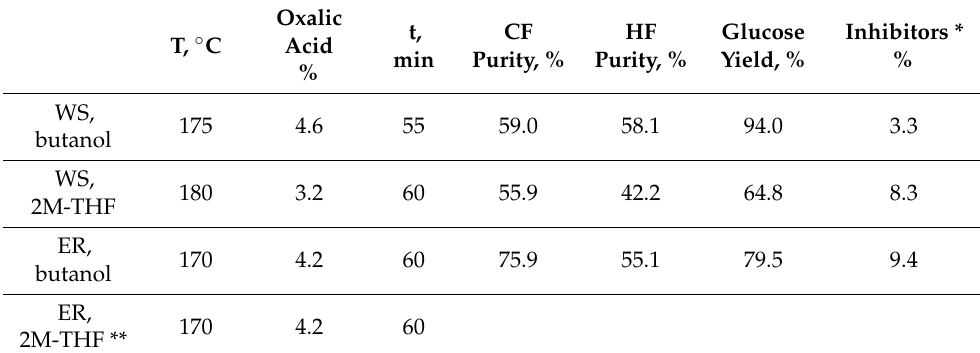
Table 5. Pretreatment conditions and responses predicted by the optimizing model for WS and ER pretreated with butanol and